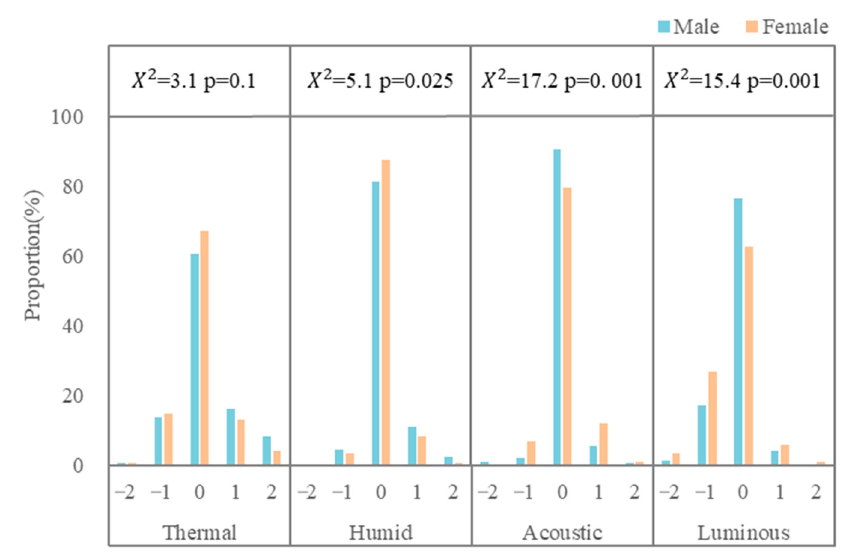
Figure 12. Environmental sensation vote of the different genders and the chi-square test result. Table 5. Ratio of positive and negative votes according to the different